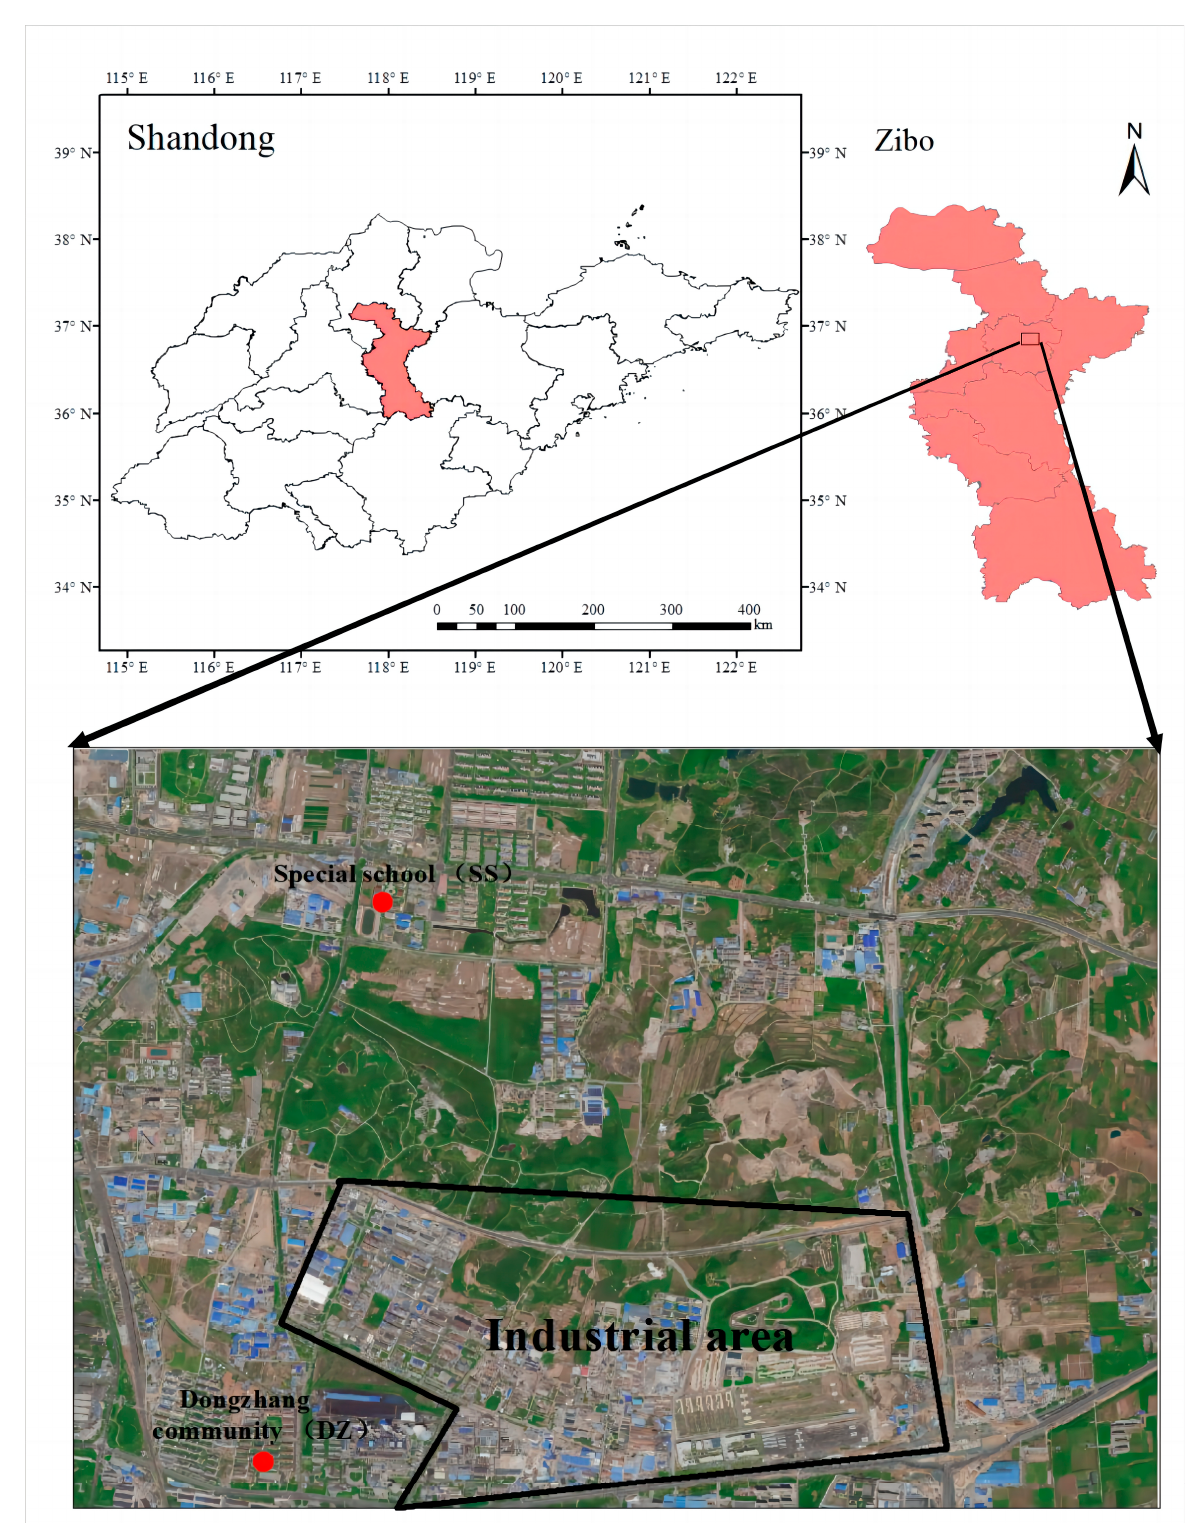
Figure 1. Location of sampling site and the surrounding areas in the industrial area.